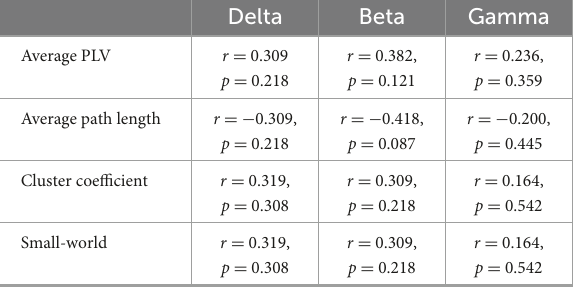
TABLE 3 Correlation (Kendall’s tau coefficient) of functional network features with the patients’ global cortical reactivity values at delta, beta, and gamma bands. Delta